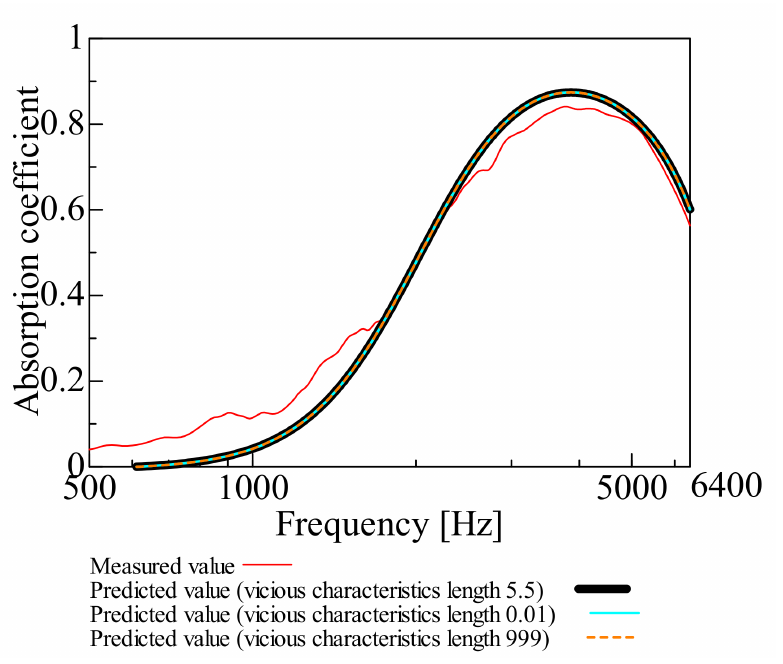
Figure 5. Variation of predicted value due to variation in viscous characteristic length: viscous characteristics length 0.01, 999, and 5.5.